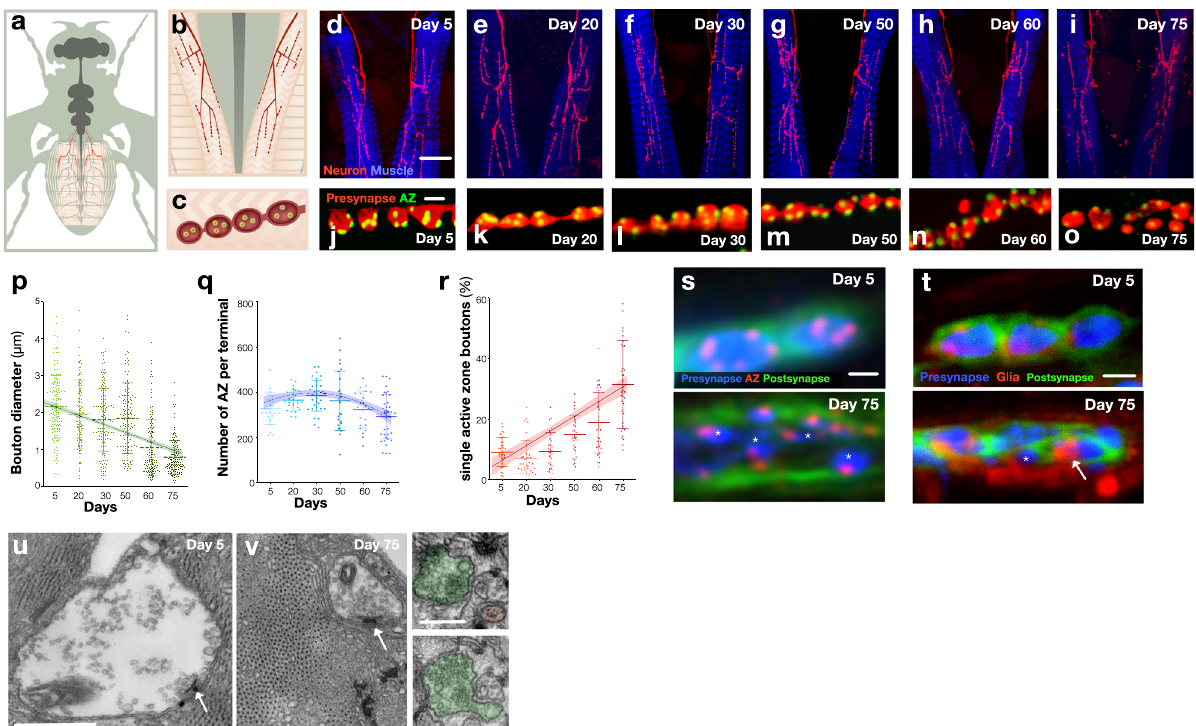
Fig. 1 Drosophila synaptic terminal structures fragment, neurotransmission declines and motor behaviour is diminished during ageing. Schematic of adult Drosophila HB9 labelled motor neurons ( a , red) which innervate a subset of ventral and dorsal muscles of the anterior abdomen including A2 mvim ( b ) producing terminal bouton varicosities ( c ) with multiple active zones of synaptic vesicle release (yellow). d – i Representative images of progressive degeneration of HB9 abdominal synaptic terminals (red, GFP) innervating A2 abdominal muscles (blue, phalloidin) from 5 days after eclosion to 75 days. Magni fi cation is identical for all images. j – o Representative images of progressive fragmentation of synaptic boutons (red, GFP) through reduction in size and number of active zones (green, Brp) per bouton during ageing. Magni fi cation is identical for all images. p Quanti fi cation of diminishment of bouton diameters during ageing. q Quanti fi cation of the number of active zones during ageing. r Quanti fi cation of bouton fragmentation during ageing as measured by the percentage of boutons with only a single active zone. s Representative images of presynaptic boutons (blue, mCherry) at day 5 (upper panel) and day 75 (lower panel). Boutons are labeled with the active zone marker Brp (red) and the postsynaptic membrane marker Dlg (green). Asterisks indicate fragmentation of presynaptic terminal at day 75. Magni fi cation is identical for both images. t Example of postsynaptic membrane (Green, Dlg) becoming opposed by peripheral glia (Red, mCherry) [indicated by arrow] as presynaptic terminals fragment (indicated by asterisk) (Blue, GFP) in 75-day old animals (lower panel), which is not found in 5-day-old young animals (upper panel). Magni fi cation is identical for both images. n = 4 biologically independent preparations. u , v Representative micrographs of bouton at day 5 and day 75, respectively. v (Right panels) serial micrograph shows an example of a fragmented bouton which is associated with other boutons by a thin process. Arrows indicate T-bars. n = 11 ( u ) and 5 ( v ) biologically independent preparations. One-way ANOVA, *** p < 0.001, R 2 = 0.28, n = 150 boutons per timepoint ( p ), *** p < 0.001, R 2 = 0.11, n ≥ 21presynaptic terminals per timepoint ( q ), *** p < 0.001, R 2 = 0.48, n ≥ 27 presynaptic terminals per timepoint ( r ), Tukey ’ s multiple comparison tests were used to compare the mean of each timepoint with the mean of all other timepoints (ns = not signi fi cant, * p ≤ 0.033, ** p ≤ 0.002, *** p ≤ 0.001). All statistical analysis details with a precise value of ‘ n ’ are reported in Supplementary Table 2 and in Source Data fi le. Scale bars, 40 μ m ( d – i ), 2 μ m ( j – o , s , t ), 500 nm ( u , v ), 250 nm ( v , right panel). Data are represented as mean ± SD. n = biologically independent